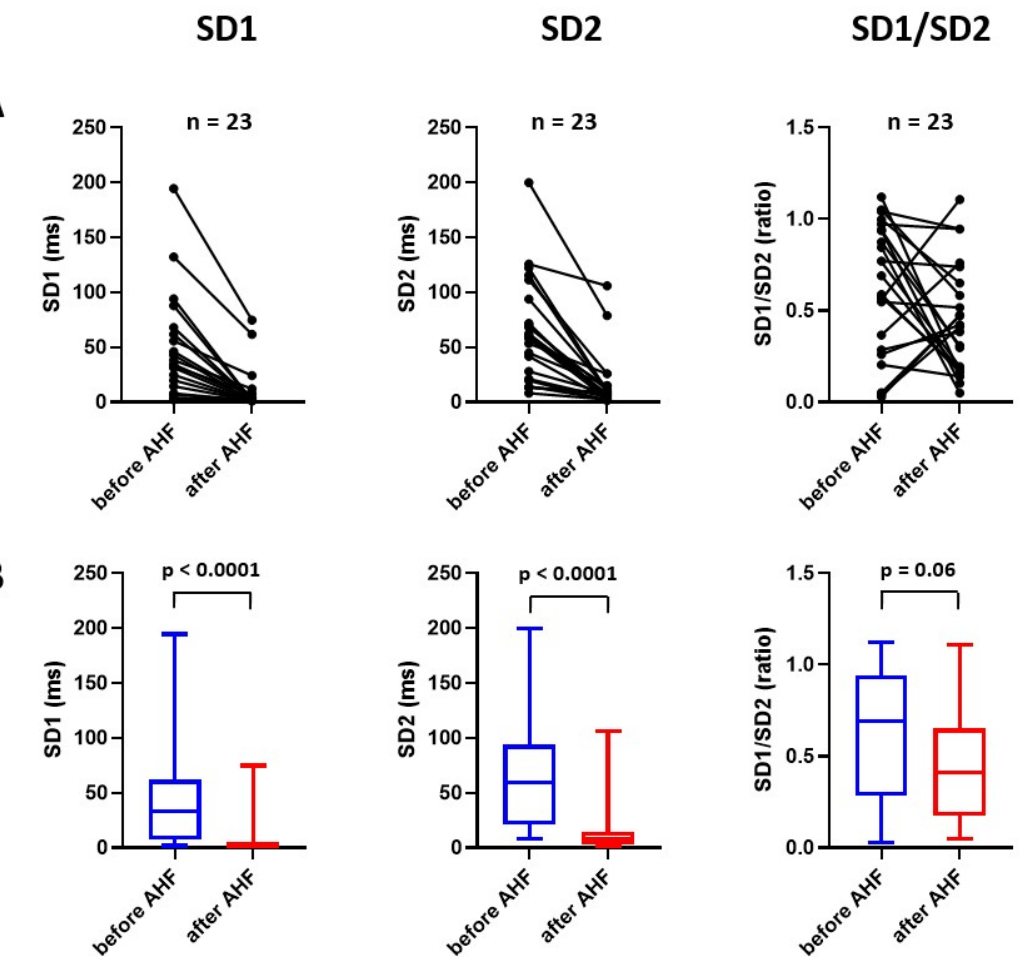
Figure 4. Effect of acute heart failure on nonlinear analysis of heart rate variability displayed as individual graph ( A ) and as median with interquartile range, minimum and maximum value ( B ). AHF = acute heart failure; SD1 = standard deviation of the points along short semi-axis of an ellipse fitted to Poincaré plot; SD2 = standard deviation of the points along long semi-axis of an ellipse fitted to Poincaré plot.